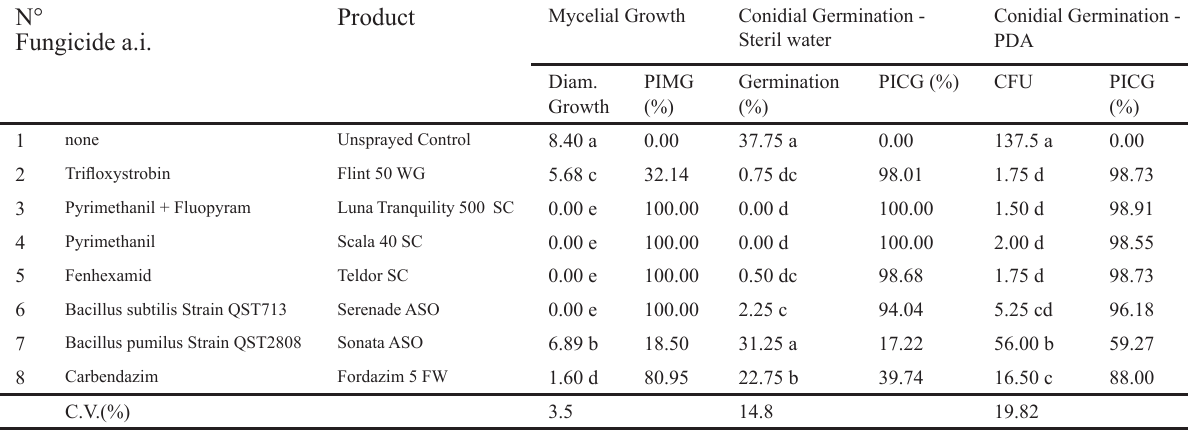
Table 2. Effect of chemical and biological fungicides in in vitro tests for mycelial growth and conidial germination of Botrytis